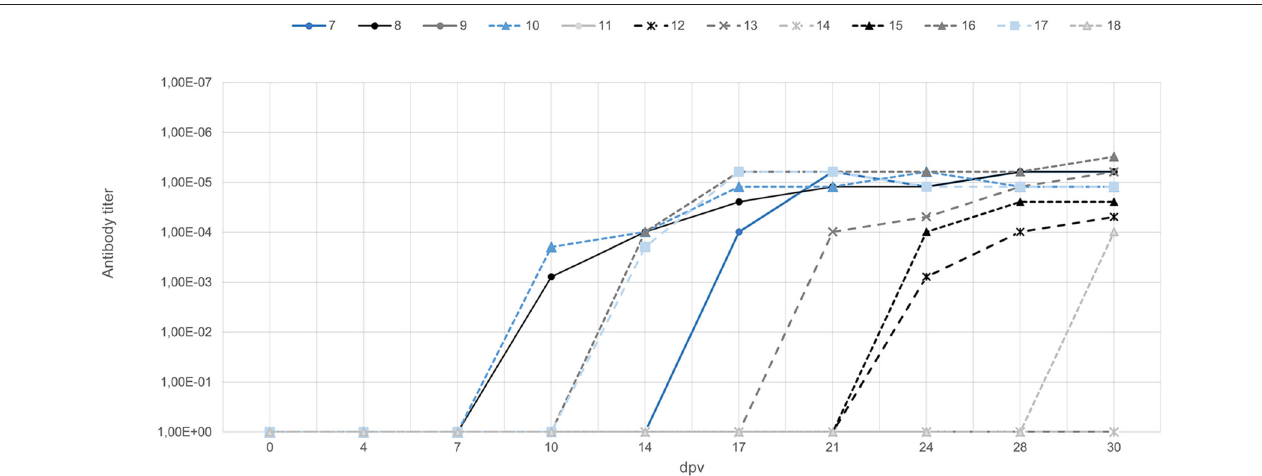
FIGURE 1 | Titers of antibody against ASFV in wild boar orally vaccinated with Lv17/WB/Rie1 (gray) and wild boar exposed through contact with vaccinated animals (blue). The latter animals were exposed through contact starting from 0 days (animal ID7), 7 days (ID10), and 15 days (ID17) after vaccination. Titers were determined using the indirect immunoperoxidase test.